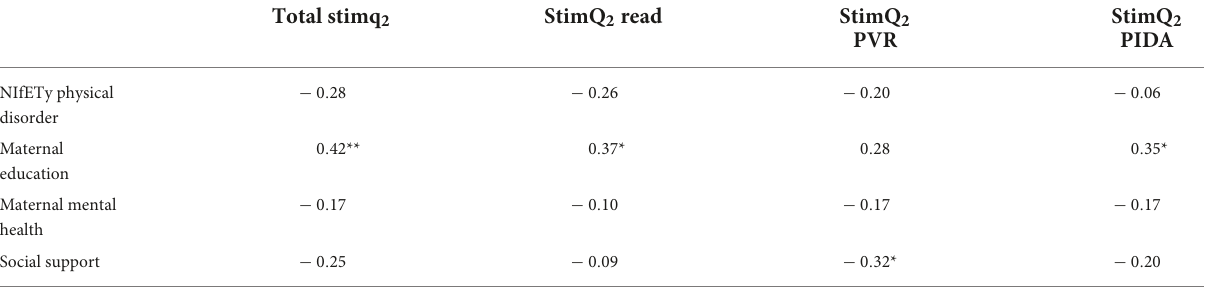
TABLE 4 Standardized regression coefficients for models predicting parent cognitively stimulating behaviors from observed physical disorder.